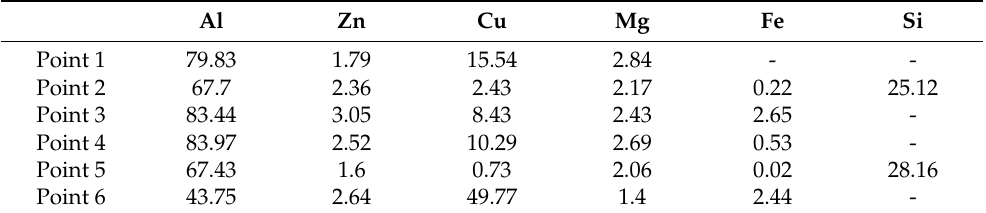
Figure 3. The SEM backscattered electron images of the as-received 7075 aluminium alloy in ED plane for: ( a , b ) sample at the edge position of the as-extruded rod; ( c , d ) sample at the centre position of as-extruded bars. Table 2. EDS results (at.%) of secondary phases of as-extruded 7075 aluminium alloy marked in Figure 3.